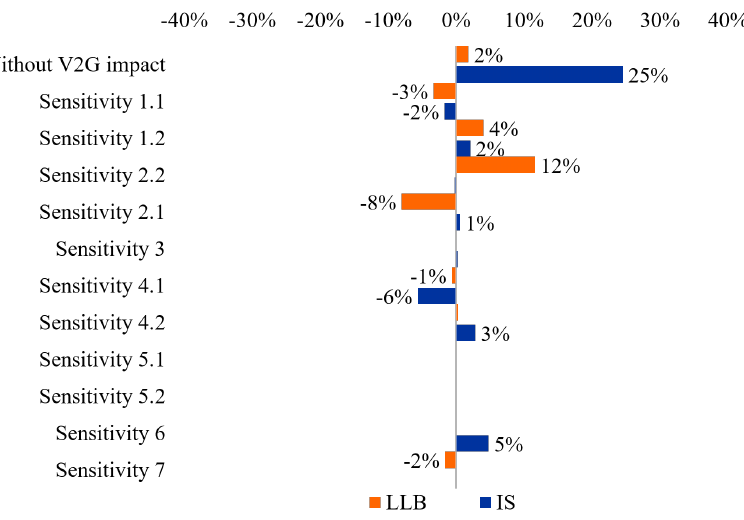
Figure 13. Relative change of V2G TCO for a Nissan Leaf in a private charging case (source: own compilation).